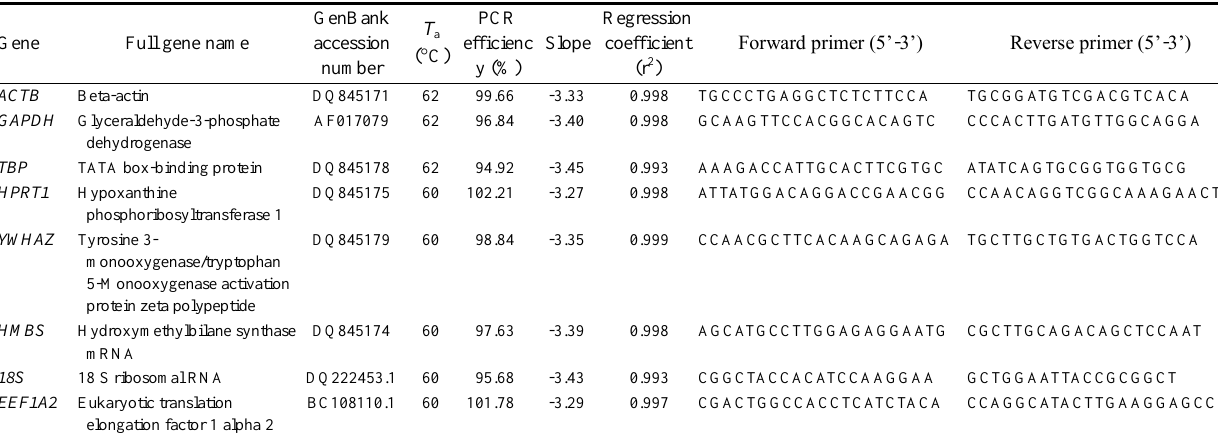
Table 1. Selected candidate reference genes used in the qRT-PCR assay indicating name, GenBank accession number, annealing temperature ( T a ), PCR efficiency, slope, regression coefficient and primers used for the expression